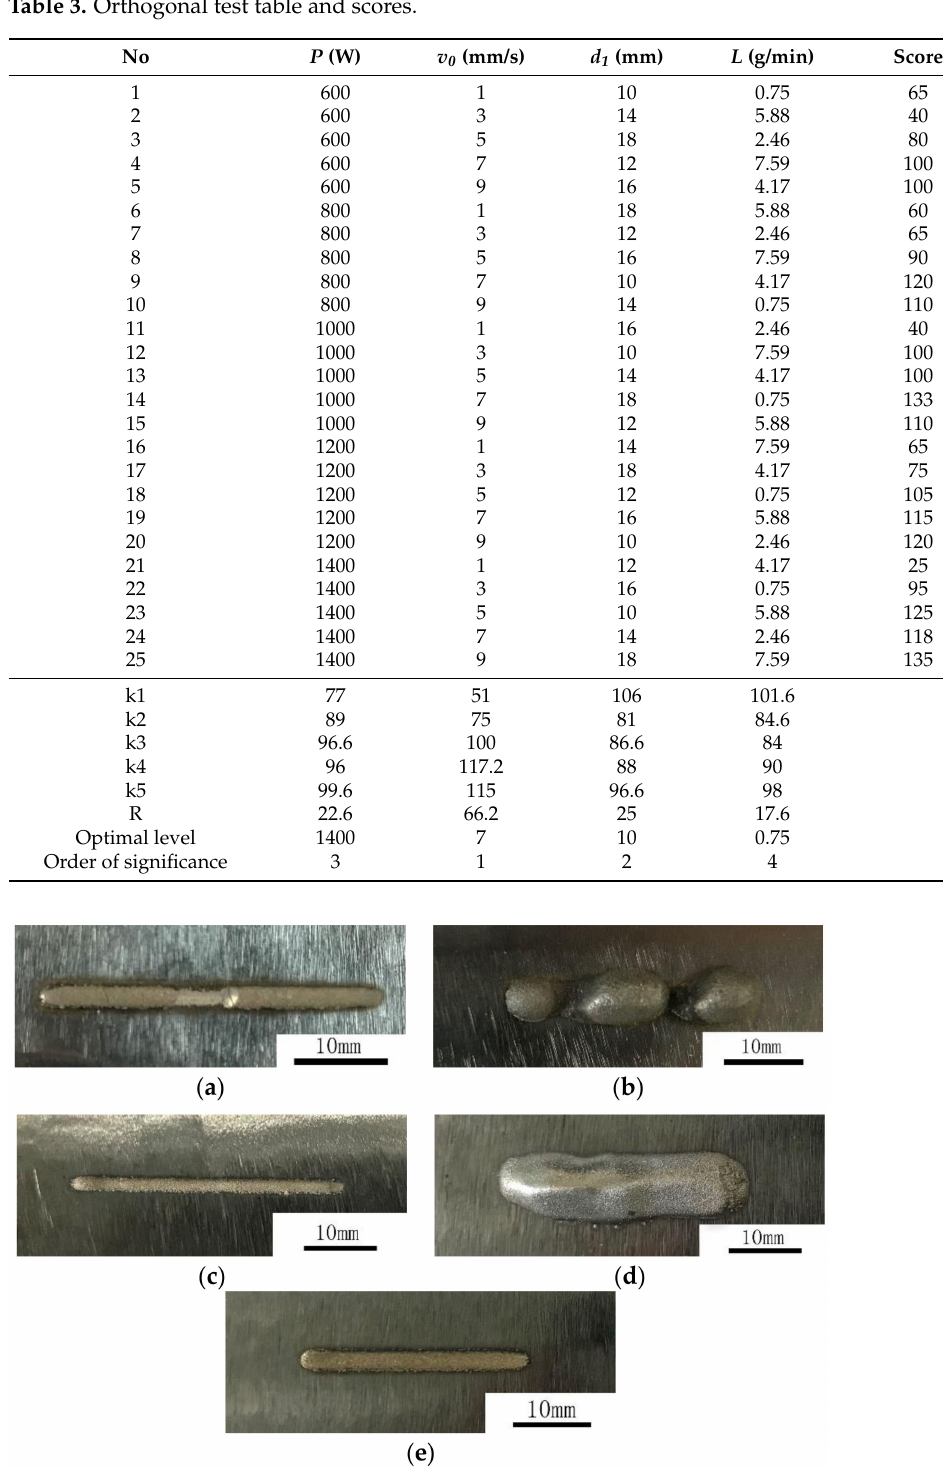
Figure 3. Morphology of specimens in the orthogonal test. ( a ) No. 3; ( b ) No. 6; ( c ) No. 9; ( d ) No. 21; ( e ) No.